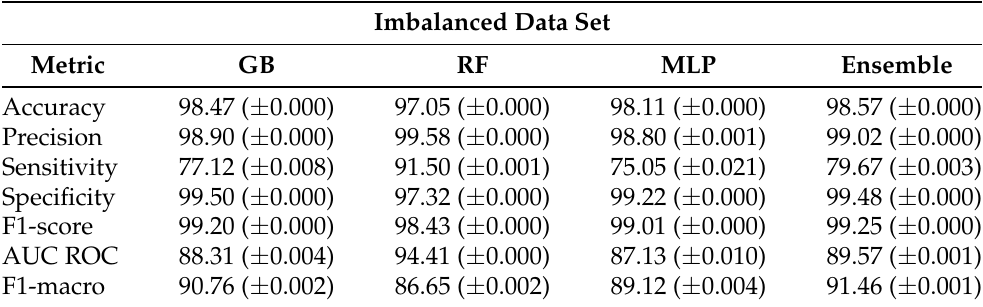
Table 5. Results of metrics (in %) and associated standard deviation for model testing using the imbalanced data set.